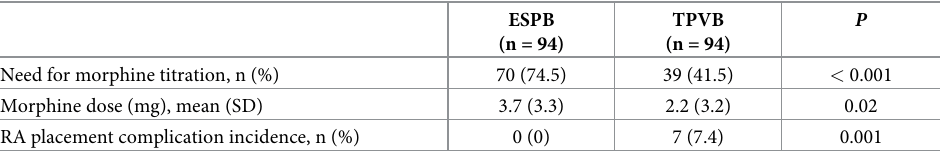
Table 2. Primary and secondary outcomes in propensity score-matched